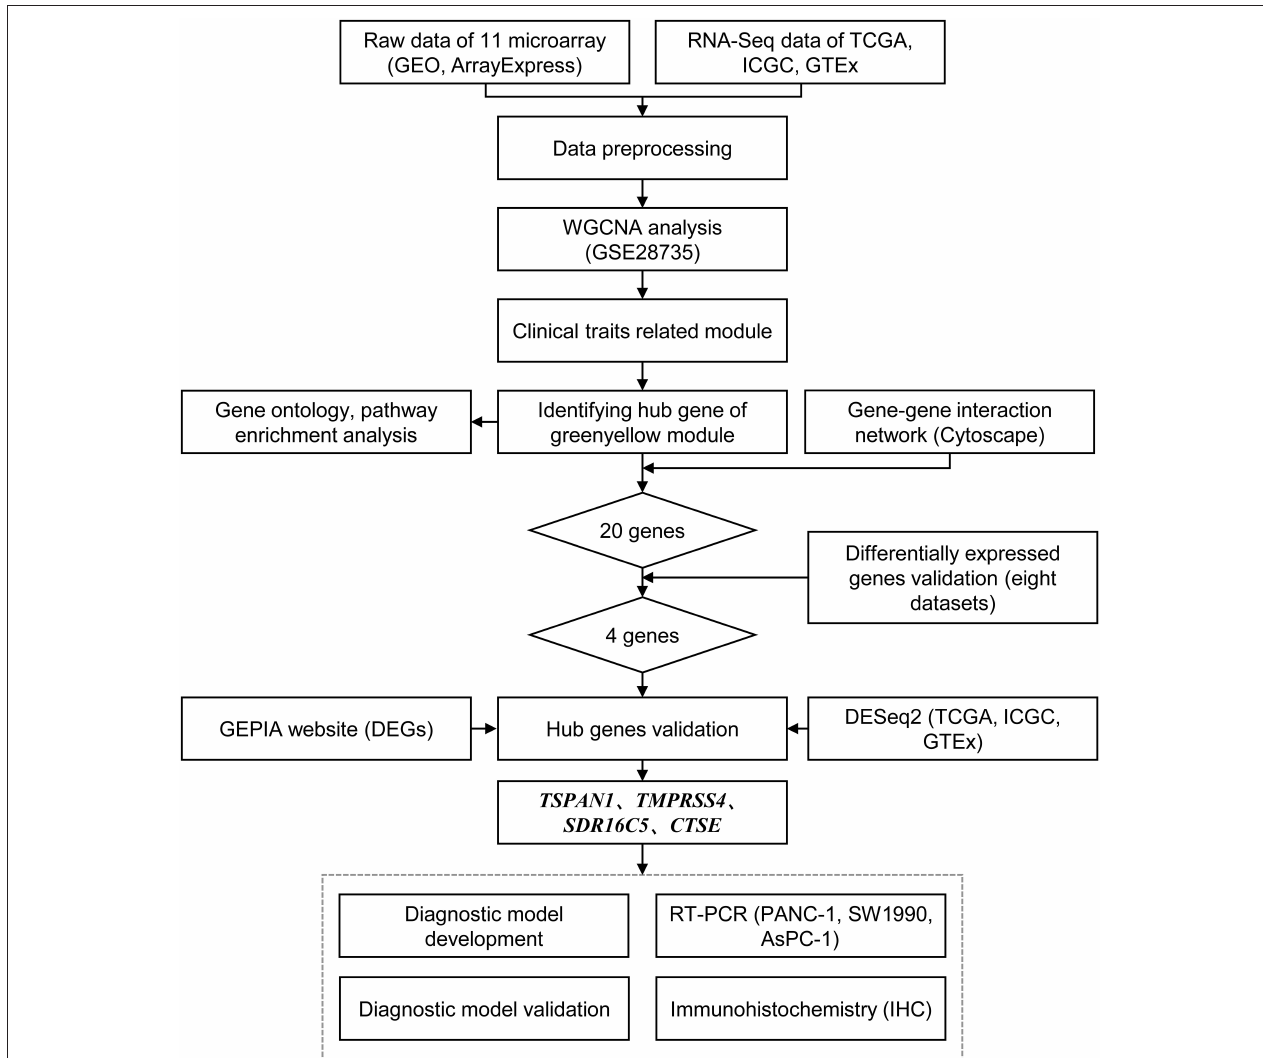
FIGURE 1 | Flow chart of data preparing, analysis, validation, and model